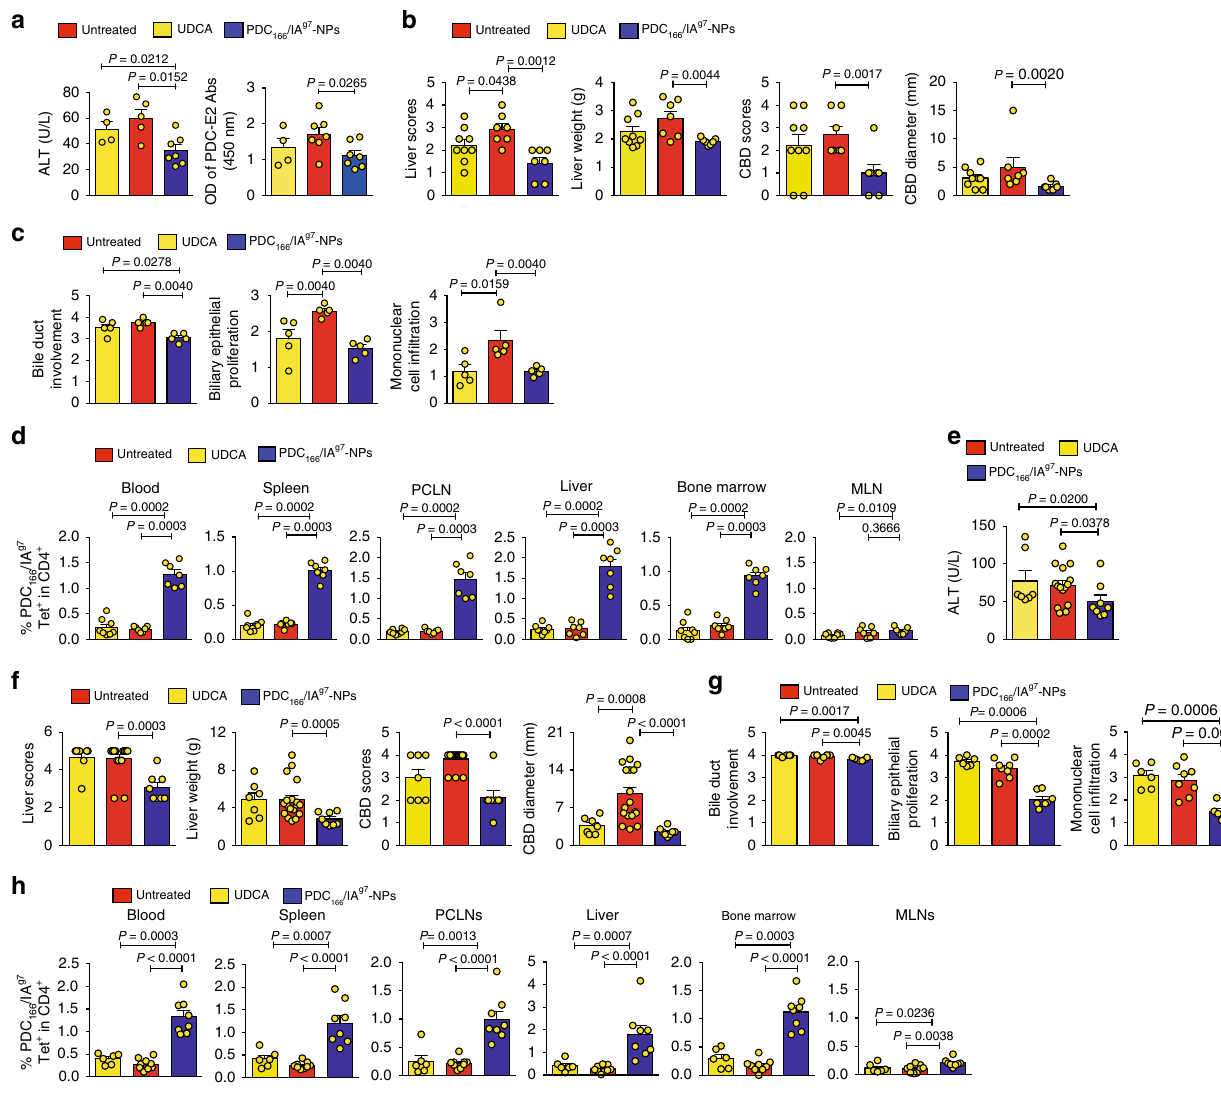
Fig. 7 pMHCII-NPs versus the standard of care in PBC. a – c Effects of treatment with PDC 166 – 181 /IA g7 -NPs or the standard of care in PBC (UDCA) on serum ALT ( a; n = 4, 5, and 7, from left to right, respectively), macroscopic ( b; n = 9, 7 and 7, from left to right, respectively) and microscopic ( c; n = 5/group) disease scores, when treatment is initiated early on in the disease process (from 6 to 20 weeks of age; twice a week for PDC 166 – 181 /IA g7 -NPs or continuously for UDCA). d Percentages of tetramer + CD4 + T-cells in the mice studied in a – c . Data correspond to n = 8, 7 and 7 mice from left to right, respectively. Data in a – d are from 2 to 3 experiments/group. e – g Effects of treatment with PDC 166 – 181 /IA g7 -NPs or UDCA on serum ALT levels ( e ; n = 7, 15, and 8, from left to right, respectively), macroscopic ( f ; n = 7, 8 and 18, from left to right, respectively) and microscopic ( g ; n = 6, 8 and 7 from left to right, respectively) disease scores, when treatment is initiated at advanced stages of the disease process (from 24 to 33 weeks of age; twice a week for PDC 166 – 181 /IA g7 -NPs or continuously for UDCA). h Percentages of tetramer + CD4 + T-cells in the mice studied in e – g . Data correspond to n = 6, 9 and 8 mice from left to right, respectively. Data in e – h are from 2 to 3 experiments/group. Averaged data correspond the mean ± SEM. P values